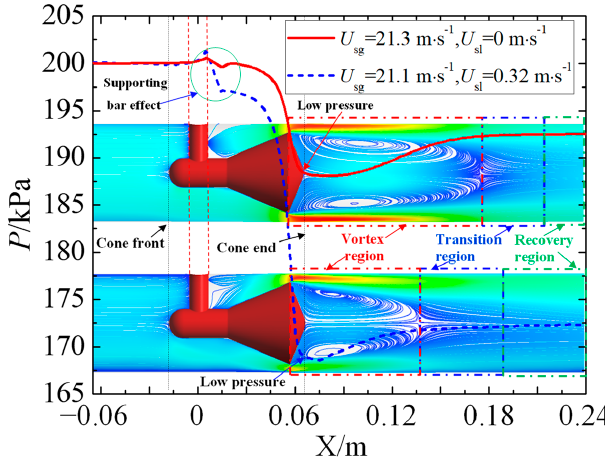
Figure 14. Effect of vortex on the wall pressure.